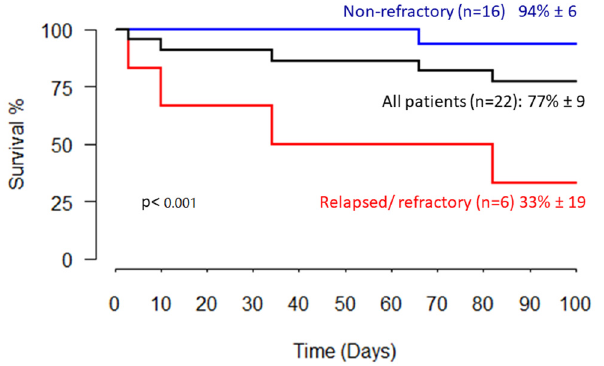
Figure 3. Outcome. Kaplan–Meier 90-day survival curves stratified according to refractory or non-refractory underlying disease.